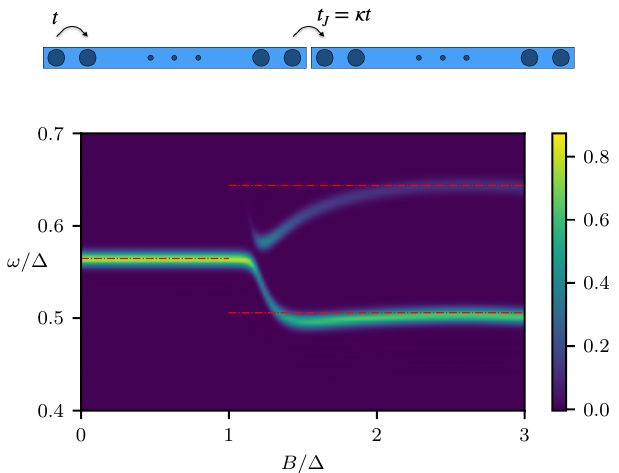
Figure 4: (a) Short junction (weak-link) model. The junction comprises a single link on which the hopping and the spin-orbit coupling are reduced by a factor κ < 1 compared to their values in the bulk. (b) Spectral function obtained with DMRG and = 0. TEBD for the weak-link model, as a function of the Zeeman energy B for N g = 0.1, E 0 = 0.5, and wire tight-binding Junction parameters in units of ∆ are E c J parameters are t = 1.5, v = 2, µ = 0, κ = 0.1. The length of each part of the = 40. In the trivial phase, for B / ∆ (cid:174) B / ∆ = 1, a single spectral line is wire is N x c seen, corresponding to the plasma frequency. As the system enters the topological phase, a second spectral line appears, and an avoided crossing between the two can be observed (see main text for further discussion). The red dashed lines correspond, for B < B , to the spectral lines expected for a conventional Josephson junction, and c for B > B , to those expected for a junction deep in the topological phase. The latter c are obtained using the minimal model given by the Hamiltonian (17) (see main text for more